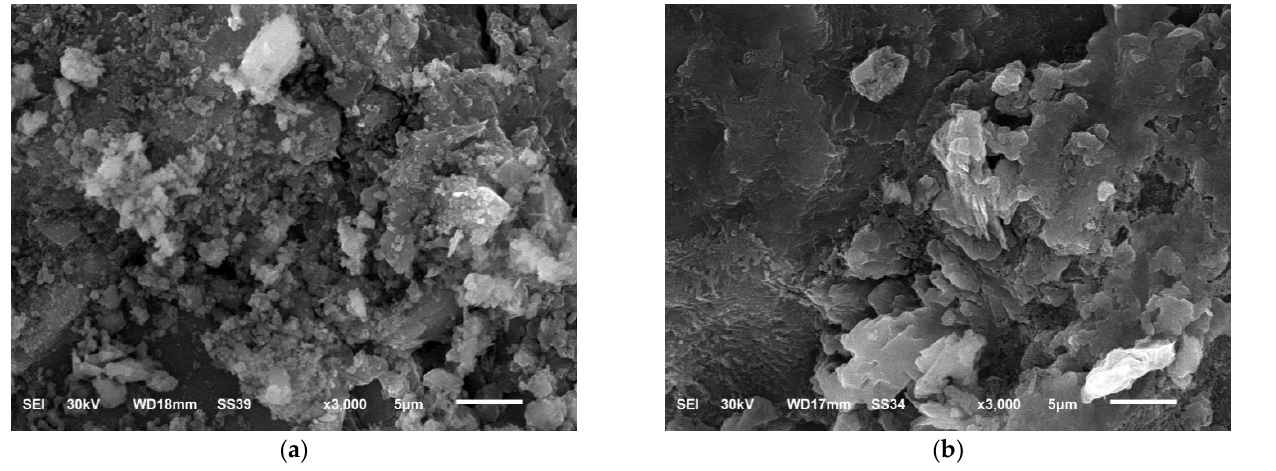
Figure 12. SEM images of the fracture surface of volcanic concrete made with MW: ( a ) 0%VA and ( b ) 5% VA.